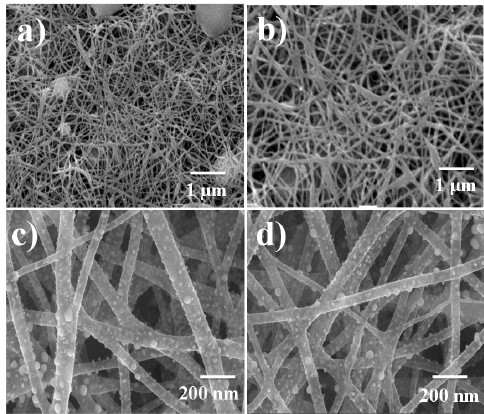
Figure 1. SEM image of electrospun NiAc / CrAc / PVA nanofiber (NF) mats after vacuum drying; ( a ) and ( b ), and field-emission scanning electron microscope (FESEM) image of the sintered powder sample; ( c ) and ( d